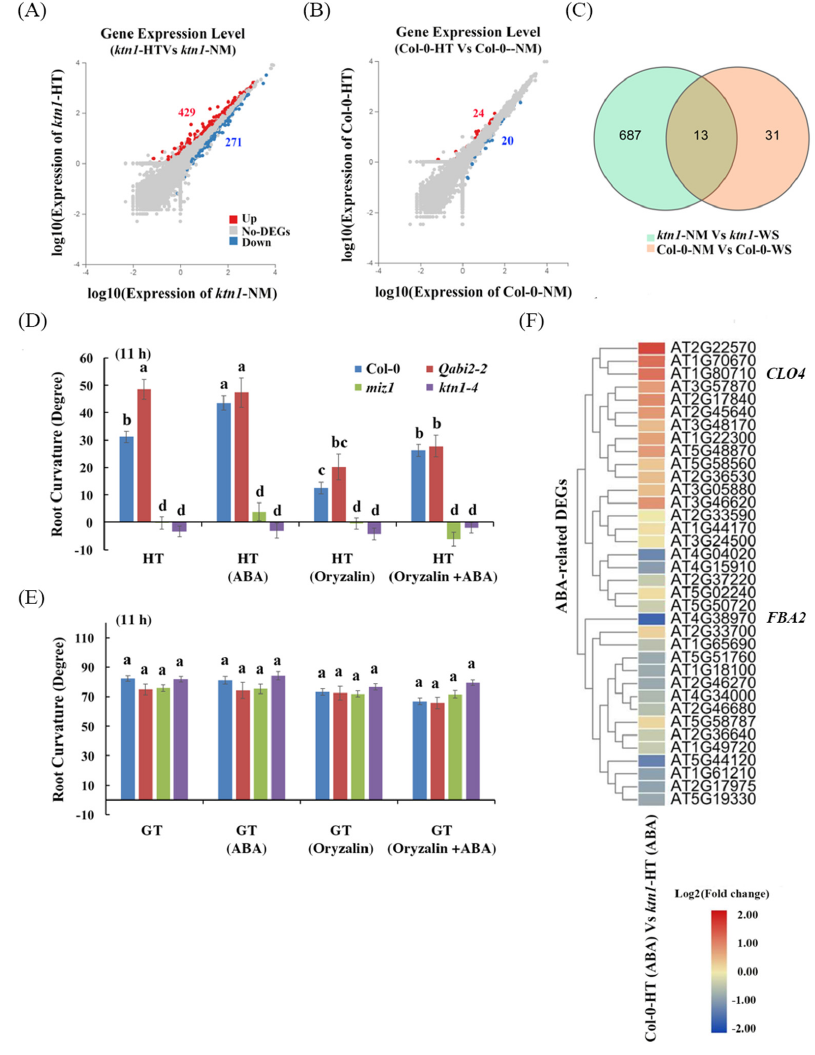
Figure 4. ABA enhances root curvatures of WT Col − 0 and partially rescues the oryzalin-alterative root curvatures of WT but not miz1 and ktn1 − 4 mutants after hydrostimulation treatment. (A and B) Scatter plots of transcript abundance of ktn1 ( A ) and Col − 0 ( B ) roots in the hydrotropism assay for two days. Red, blue, and gray dots represent upregulated, downregulated, and not differently ex- pressed genes, respectively (probability ≥ 0.95 and log 2 Ratio ≥ 1). ( C ) Venn diagram showing the number of DEGs of ktn1 and Col − 0 in the hydrotropism assay. ( D ) Measurements of root curvatures of ABA and oryzalin (a microtubule destabilizer) treatments on WT, Qabi2 − 2 (an ABA sensitive mu- tant), miz1 (a lost hydrotropism mutant), and ktn1 − 4 (a microtubule-associated protein (MAP) mu- tant) after hydrostimulation treatment (HT). ( E ) Measurements of root curvatures of ABA and oryzalin treatments on WT, Qabi2 − 2 , miz1, and ktn1 − 4 mutants after gravistimulated treatment (GT). Error bars indicate SE; n = 36. Lower case letters show significant difference at p < 0.05 (Tukey’s test). ( F ) Heat map showing ABA-related differentially expressed genes (DEGs) in Col − 0 − HT (ABA) vs. ktn1 − HT (ABA). Red = high transcript level; blue = low transcript level. The transcriptional profiles of ABA-related gene expression values (log2Ratio values) were analyzed by using the heat map command of the R language, which are displayed as colors ranging from red to blue as shown in the key.